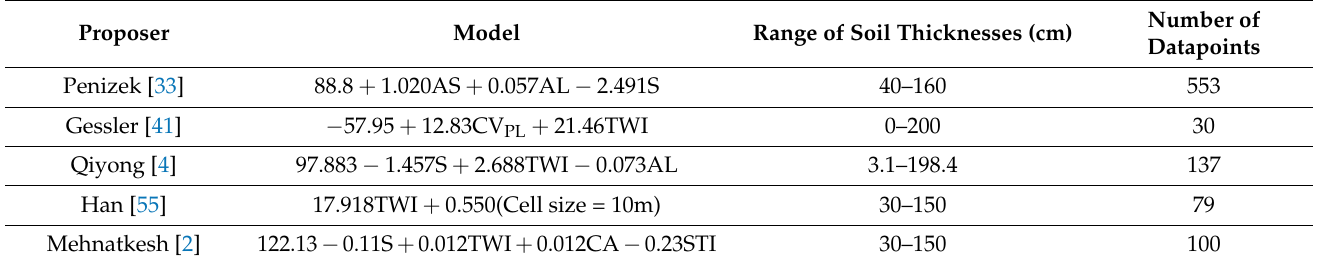
Table 4. Previously proposed statistical soil depth prediction models.